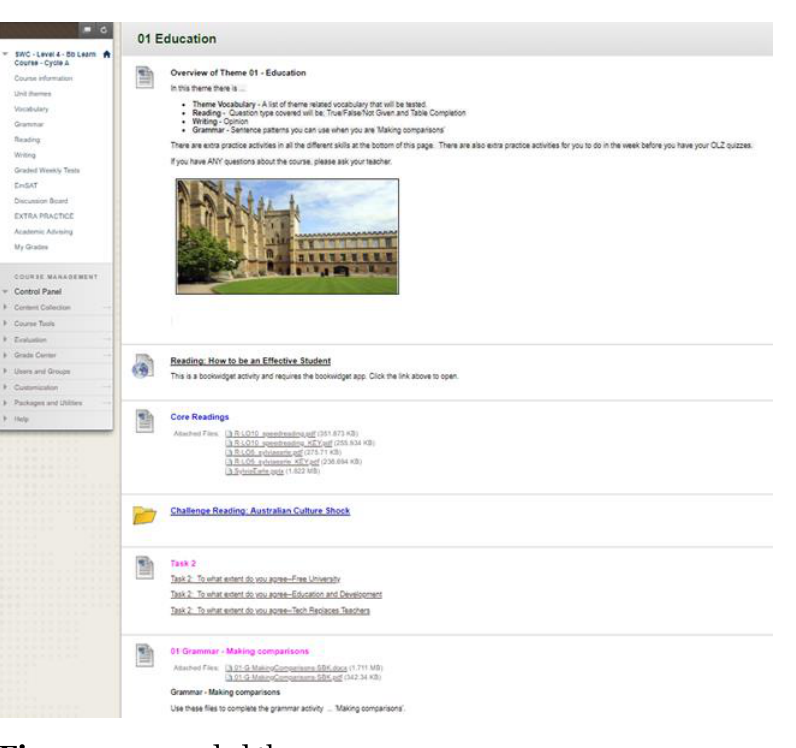
Figure 3: expanded theme